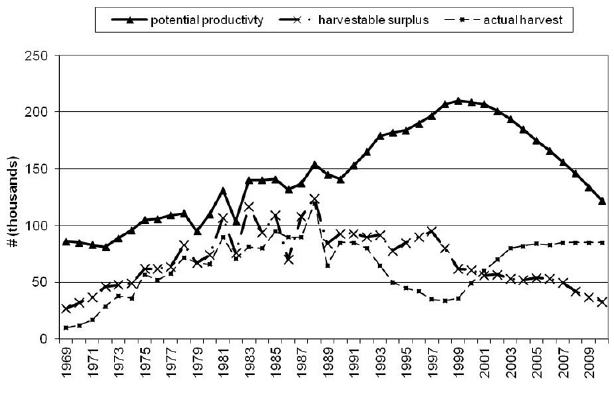
Fig. 6 . Potential productivity, harvestable surplus, and actual harvest of the Taimyr wild reindeer herd, 1969-2010. Estimates were derived from aerial population estimates during census years and modeling extrapolation in nonsurvey